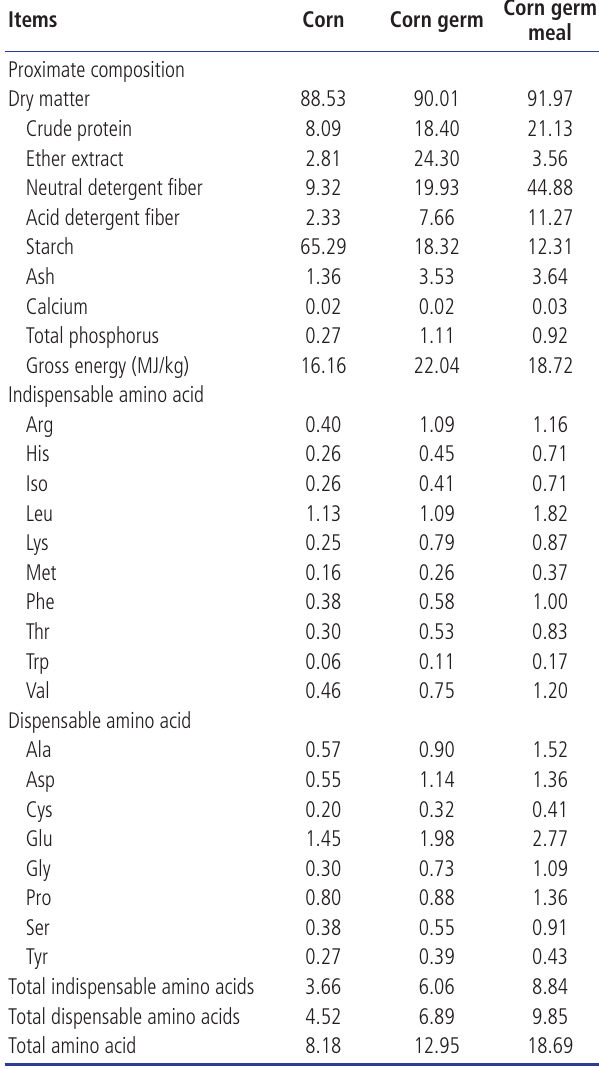
Table 1. Chemical composition of corn, corn germ, and corn germ meal used in experiment 1 and 2 (%, as-fed